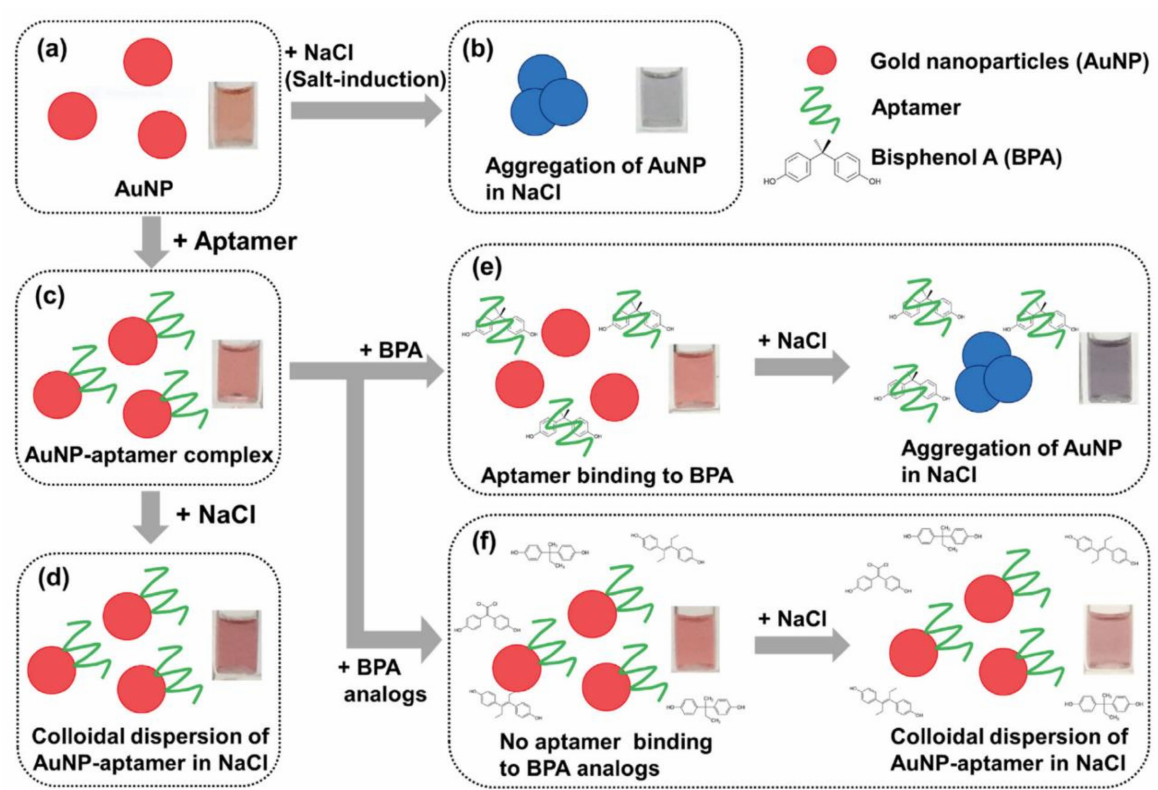
Figure 9. Scheme of the colorimetric aptasensor for the detection of bisphenol A (BPA) via salt-induced aggregation. ( a ) Colloidal dispersion of the AuNPs (AuNPs). ( b ) Electrolyte (NaCl)-induced aggregation of AuNPs. ( c ) Formation of AuNPs–aptamer complexes. ( d ) Dispersion of AuNP–aptamer complexes despite the addition of NaCl. ( e ) Aggrega- tion of AuNP–aptamer complexes resulting from the binding of aptamer to BPA and the subsequent addition of NaCl. ( f ) Dispersion of AuNP–aptamer complexes in the presence of NaCl resulting from the low binding affinity of the aptamer to BPA analogs. Inset photographs of each box are the corresponding solutions. Reprinted with permission from ref. [113]. Copyright2019,